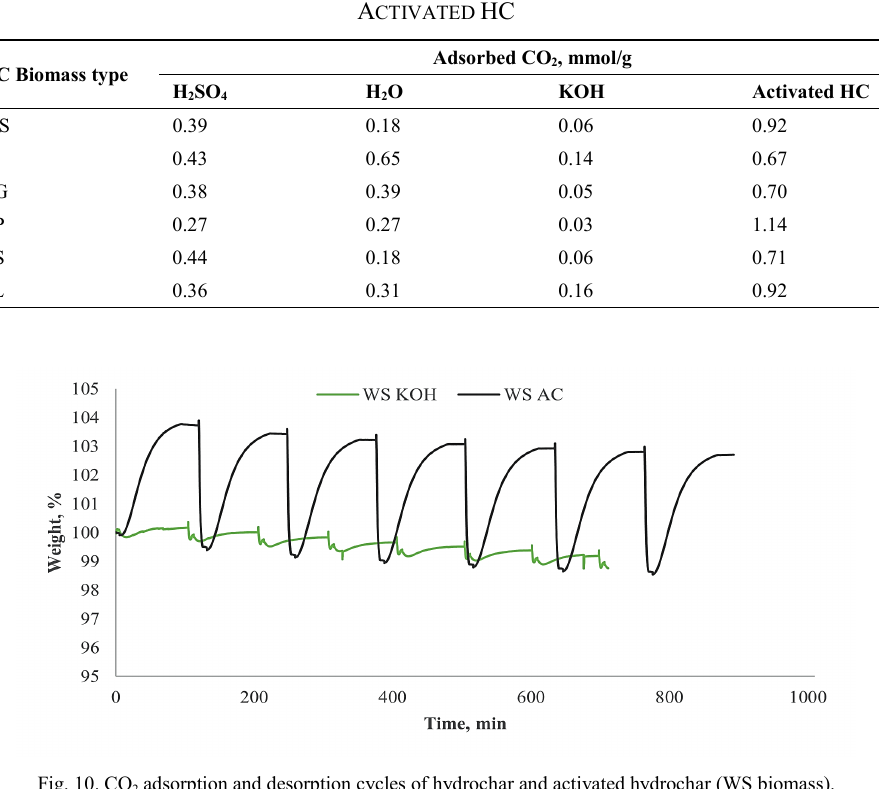
Fig. 9. Thermogravimetric analysis of hydrochars obtained during hydrothermal carbonization process in neutral and acidic environment (WS biomass, 24 h, 200 °C). T ABLE 2. A BILITY OF H YDROCHARS O BTAINED F ROM D IFFERENT B IOMASS TO A DSORB CO 2 D EPENDING ON THE C ATALYST (H 2 SO 4 , KOH, H 2 O) U SED BY HTC IN C OMPARISON TO